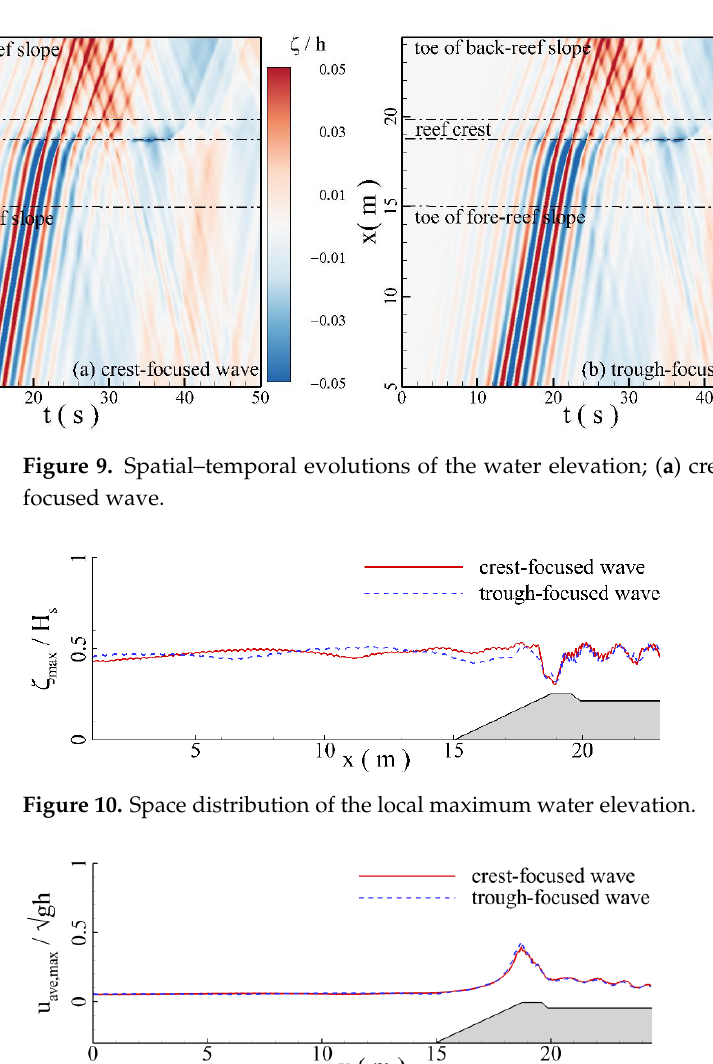
Figure 8. Comparisons of the water surface elevations.